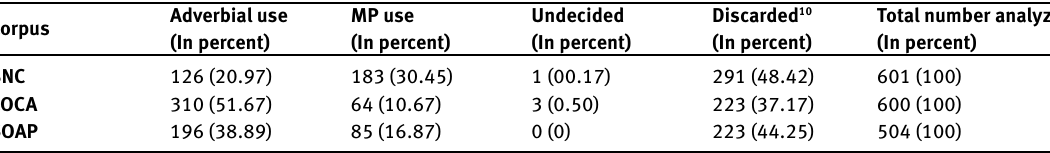
Table 1: Modal particle uses of final then in the three corpora